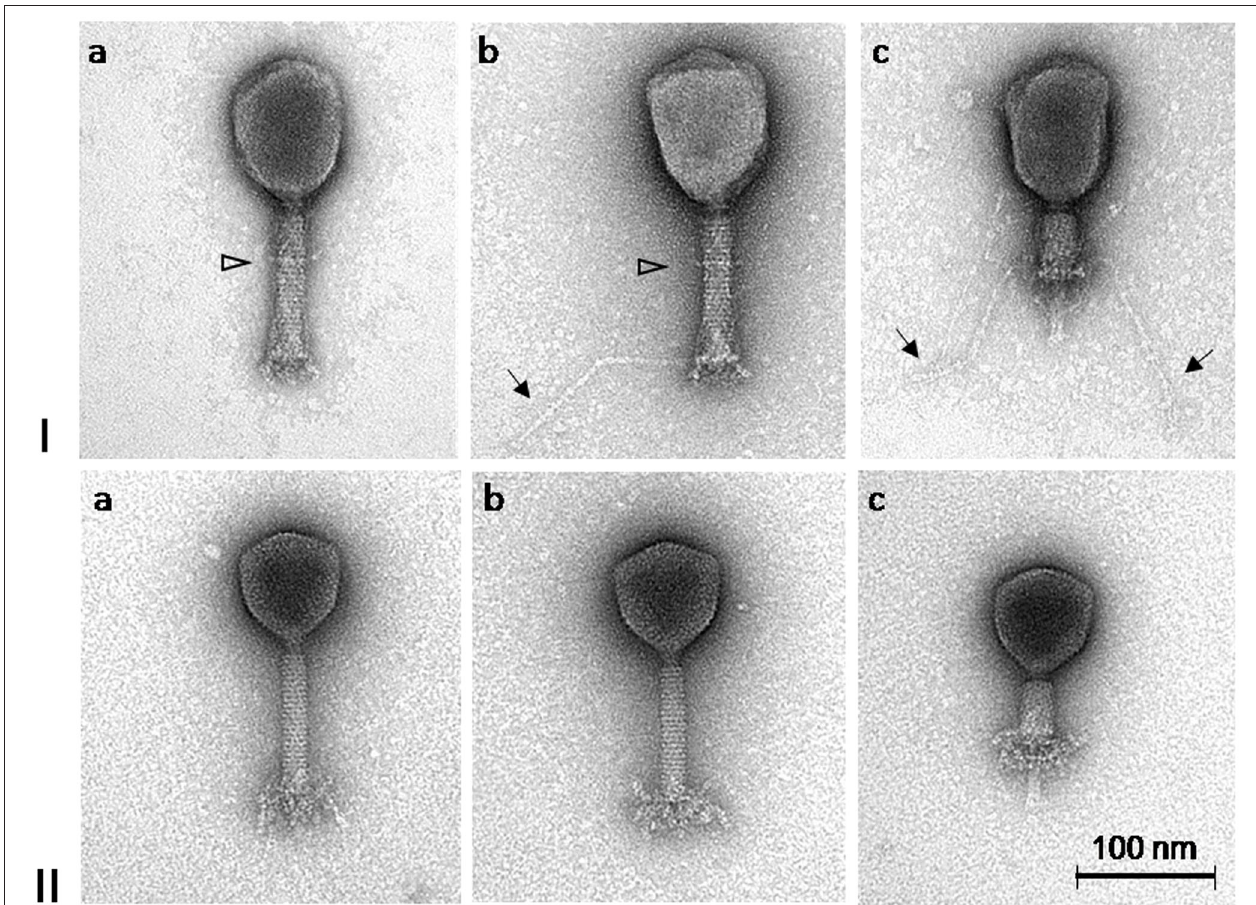
FIGURE 2 | Transmission electron micrographs of A. baumannii phages ISTD (I) and NOVI (II) negatively stained with 1% (wt/vol) uranyl acetate. Extended long tail fibers of phage ISTD are indicated by arrows in Ib and Ic. A distinct ring structure on the tails of phage ISTD is indicated by a triangle (Ia and Ib). Phages with contracted tail sheaths and protruding tail tubes are shown in Ic and IIc, respectively. Head dimensions: ISTD, 113.9 ± 4.4 × 83.0 ± 4.0 ( n = 10); NOVI, 83.0 ± 1.8 ( n = 8). Tail length incl. bp appendages: ISTD, 123.3 ± 1.8 ( n = 9); NOVI, 125.7 ± 2.9 ( n = 8). Tail length without bp appendages: ISTD, 110.0 ± 1.8 ( n = 10); NOVI, 107.2 ± 2.2 ( n = 8). Tail width: ISTD, 21.8 ± 1.3 ( n = 9); NOVI, 19.6 ± 0.5 ( n = 8). Long tail fiber length: ISTD, 148.7 ± 10.6 ( n = 17); NOVI, N/A. All dimensions are given in nm.